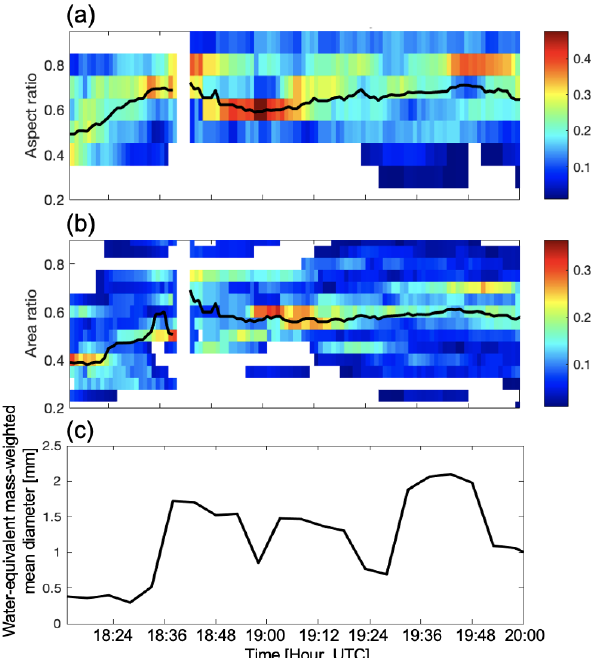
Figure 11. Time series of (a) aspect ratio and (b) area ratio of snow particles measured by the MASC and (c) water-equivalent mass- weighted mean size of Parsivel-measured PSDs. Color shades and black lines in (a, b) represent normalized frequency and median values, respectively, for snow particles collected during a 15min window every